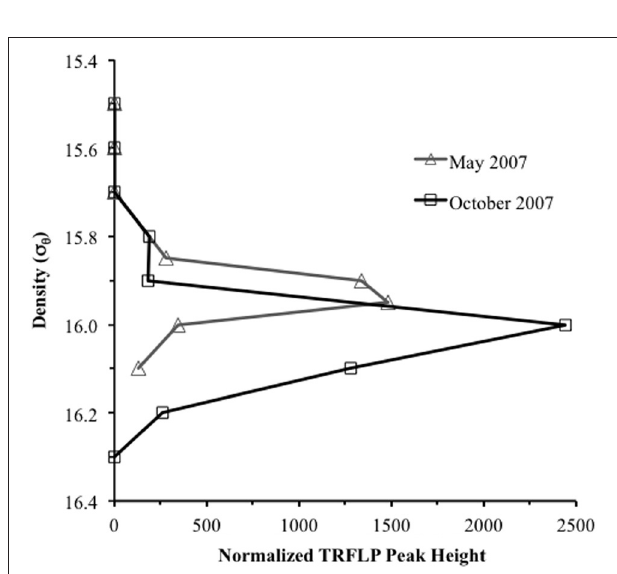
FIGURE 5 | Terminal restriction fragment length polymorphism (TRFLP) profile of “ Candidatus Scalindua” 16S ribosomal DNA for May and October 2007. Products were amplified using Planctomycetes specific primers 58F and 926R, and peak identification obtained with enzymes HaeIII , Hpy1881 , MspI . Profiles were normalized downward by total peak height.